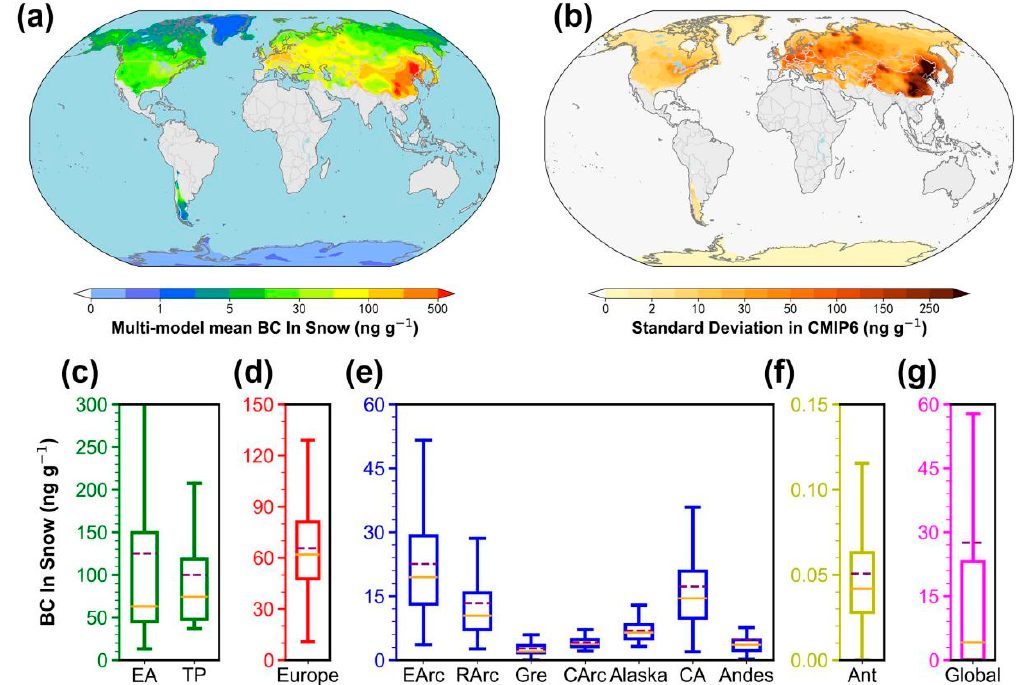
Figure 2. ( a ) Multi-model mean BC concentrations in snow (BCS) averaged over 1980–2014. ( b ) Inter-model standard deviation of BCS concentrations for the seven individual-model outputs, 1980–2014. ( c – g ) Statistics for multi-model mean regional and global BCS concentrations with mean values (purple dashed lines) and median values (orange solid lines).